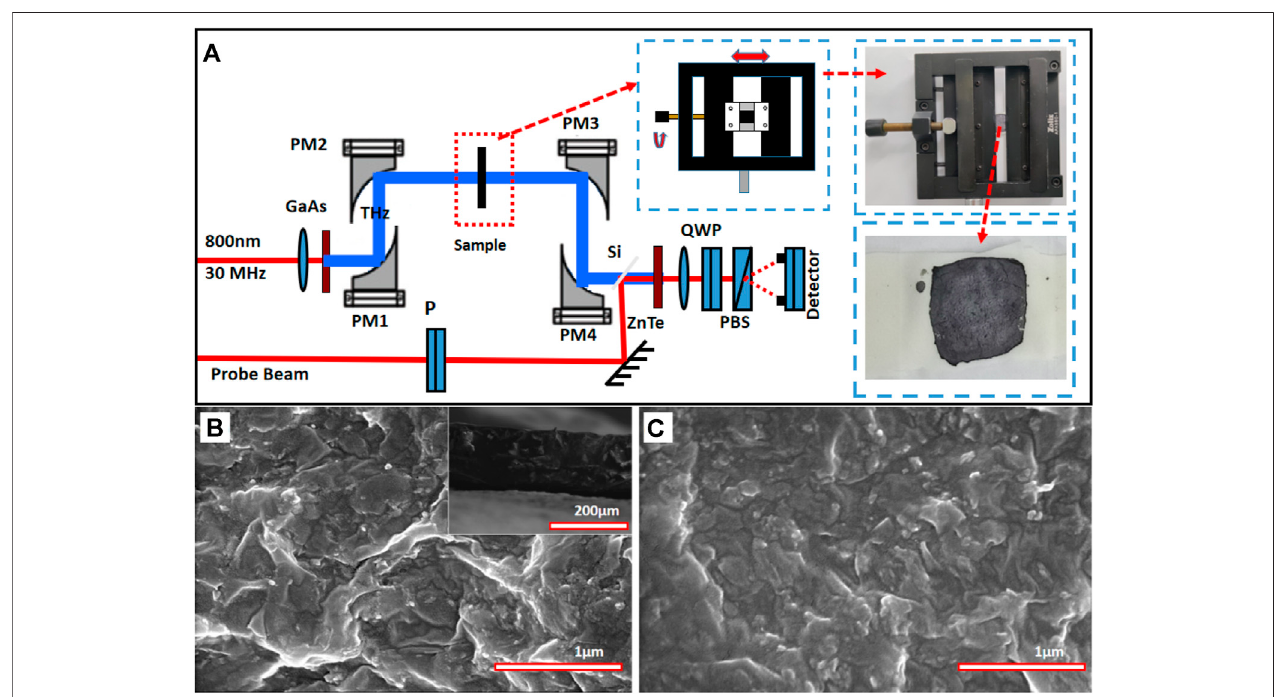
FIGURE1|(A) Schematicoftheexperimental setup. (B) Surfacemorphologyofthesamplewithouttension. (C) Surfacemorphologyofthesampleundertension.